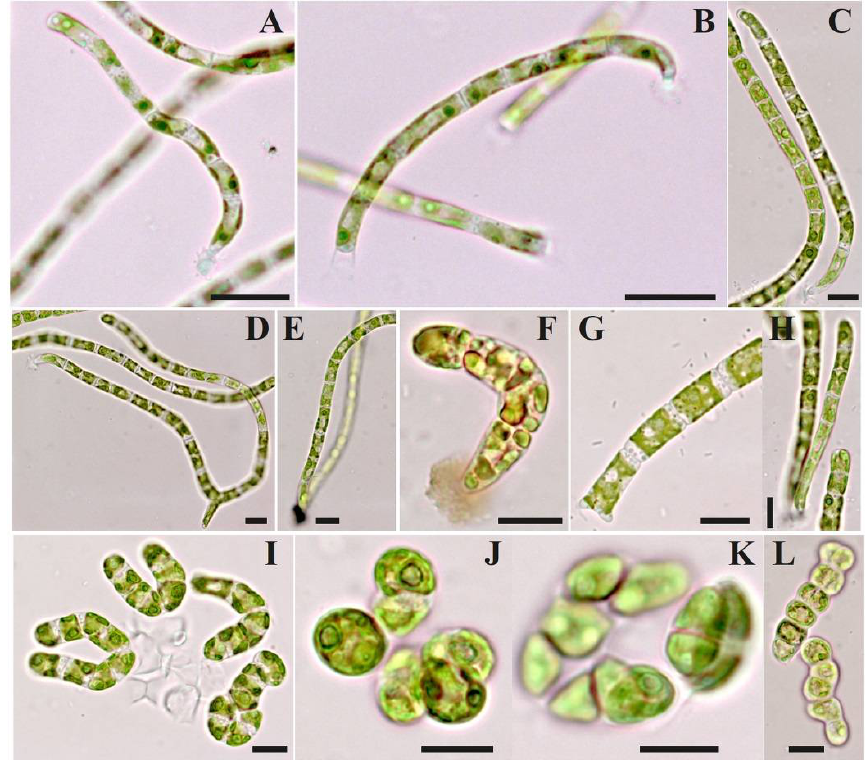
Figure 5. Growing filaments and cell aggregates of the strain IRK–A 341. ( A – H ). Filaments with the apical-basal polarity. ( A – D , F – H ). Filaments with a holdfast and/or ring-like structure. ( I – K ). Germinating cells from resting or vegetative cells. ( L ). Filaments similar with protococcalean algae. ( A – E , G – L ). The culture from mineral medium. ( F ). The culture from soil medium. Scale bars: ( A – E , H )—20 µm, ( F , G , I – L )—10 µm.